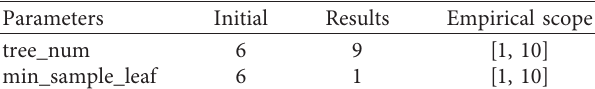
Figure 5: Flowchart of the hyperparameters for RF tuning by BAS during training and testing. Table 4: Final hyperparameters of